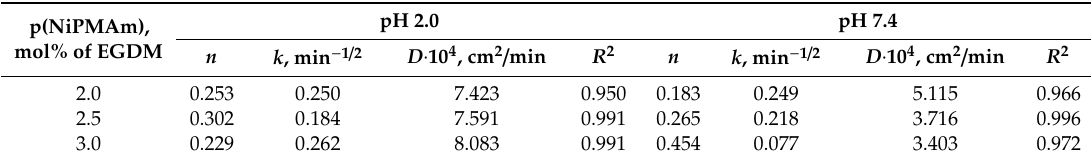
Table 2. The calculated values of kinetic parameters ( n , k , and D ) of fluid (pH 2.0 and 7.4) di ff usion into p( N iPMAm) hydrogels at 20 ◦